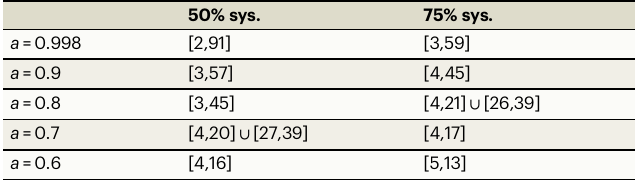
Table 1 | Projected exclusion ranges of spin-1 ULB masses 50%